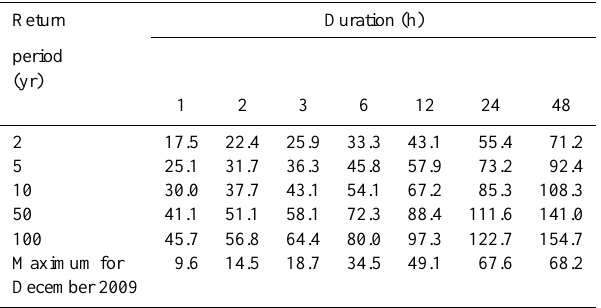
Table 2. Maximum rainfall (mm) according to return period and maximum observed in December 2009 for the S18SCDC2 station (Brandão et al.,